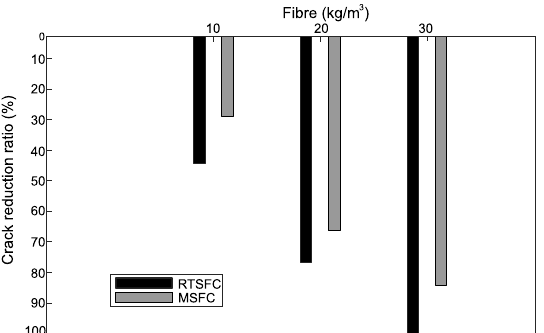
Figure 18. Crack reduction ratio (CRR) in specimens containing RTSF and MSF at 24 h.